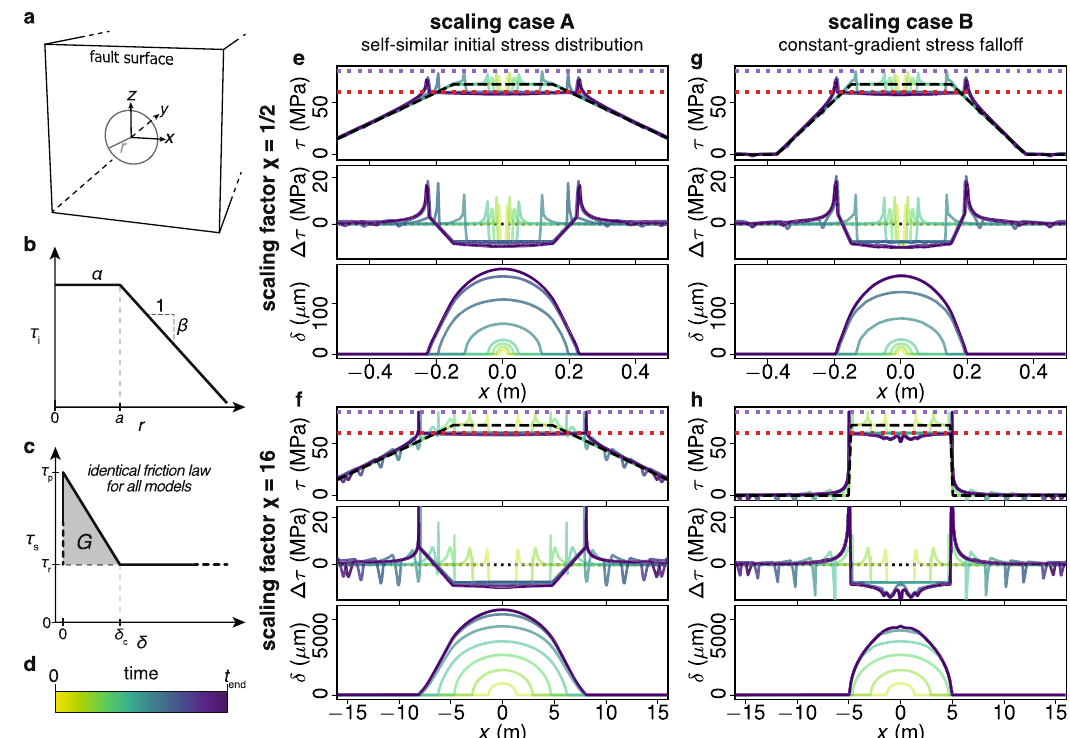
Fig. 1 Nucleation and arrest of simulated earthquake at fault with non-uniform initial stress. a Schematics of the numerical model, where the fault surface is de fi ned on the xz plane ( y = 0) and embedded in a homogeneous elastic full space. b Parametric initial stress distribution where α is the initial stress amplitude at the plateau with radius a and β is the gradient of initial stress decrease outside the plateau. c The slip-weakening friction law where peak strength τ p , residual strength τ r , and critical slip distance δ c are identical for all models. Fracture energy G is the shaded area. d The color map for curves in ( e – h ) that indicates the simulation time, where t end is time of arrest. e – h Snapshots of stress τ , stress drop Δ τ and slip δ at y = z = 0 with χ = 2 − 1 and χ = 2 4 in scaling case A and B, respectively. Purple and red dotted lines indicate τ p and τ r from the friction law (see c),